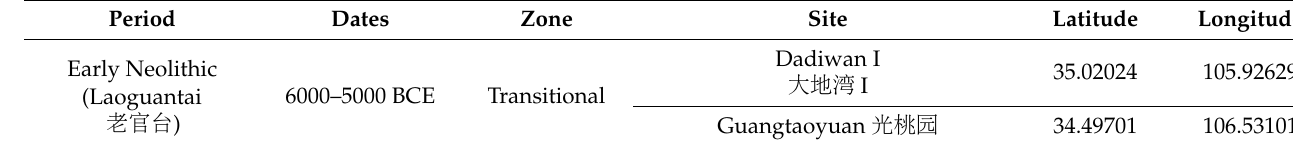
Table 1. Chronology of Northern China and coordinates of the sites included in this study. Chronolo- gies for Chinese archaeological cultures are determined on the basis of a large number of calibrated radiocarbon dates obtained from archaeological sites, which are published in